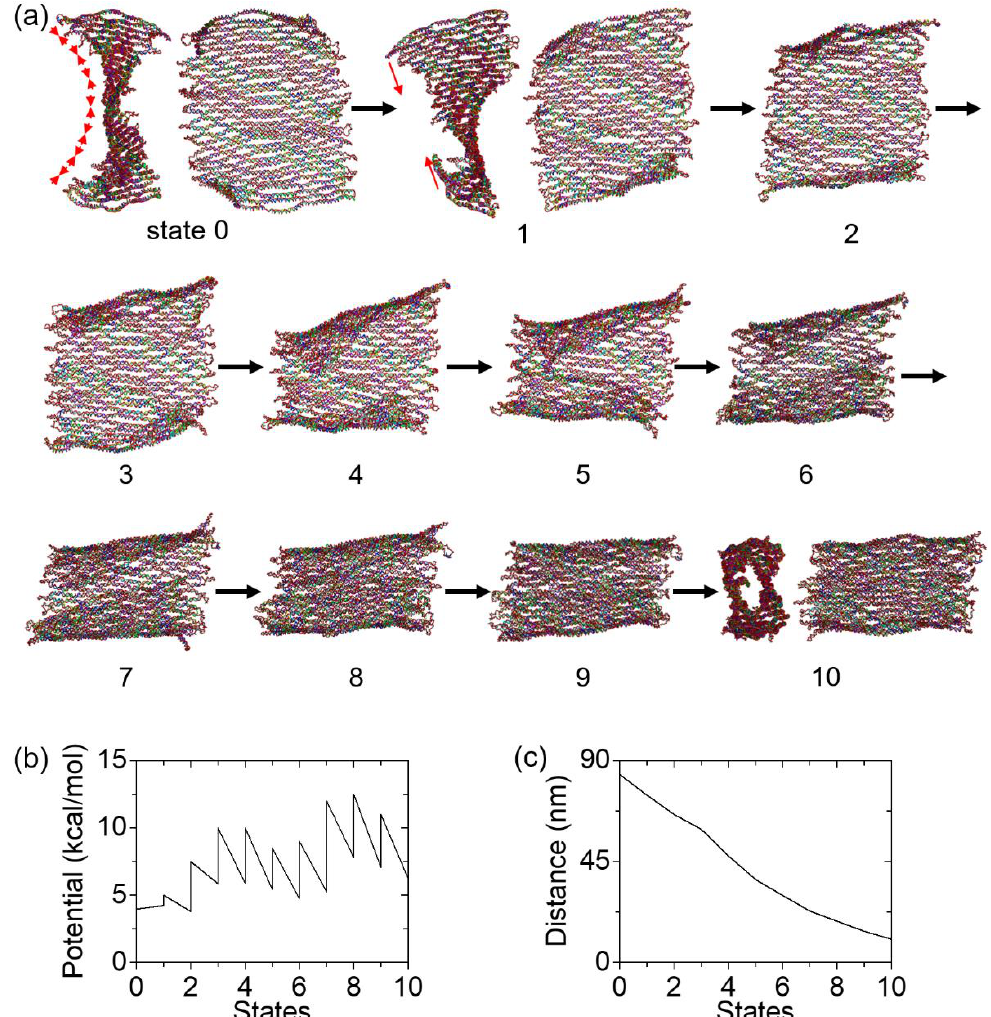
Figure 4. Deformation process of origami tile cyclization in MD simulations. ( a ) The DNA tile deforms from state 0 (initial) to state 10 (final). In the final state, the tile is cyclized into a tube. The cyclization is induced by adding hypothetical linear spring forces in the MD simulations. From state 0 to state 1, the forces were added between neighboring dsDNA bundles (illustrated by the red arrows in state 0) to create the starting conformation for the cyclization (state 1). From state 1 to 2, from 2 to 3, and all the rest until the final state, the forces were added between 13 pairs of cut sites on the linker staples (on the upper and lower edges), as illustrated by the red arrows in state 1. ( b ) Potential energy landscape associated with the applied spring forces for the cyclization. By extracting the initial and final potential energies (i.e., the potential energy of the springs) in a process from one state to the next, the external work is calculated. ( c ) Distance profile during the cyclization. This is the averaged distance between the cut sites of the linkers. The distance starts from ~84 nm (32 rows of dsDNA bundles or the height of the origami tile) and ends below 11 nm, indicating a cyclized conformation in the final state.